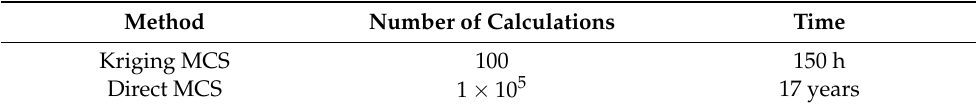
Figure 9. Wear depth of the Kriging model compared to the results of the numerical calculation: ( a ) Pinion; ( b ) Gear. Table 4. Consuming time of the MCS method and Kriging model.